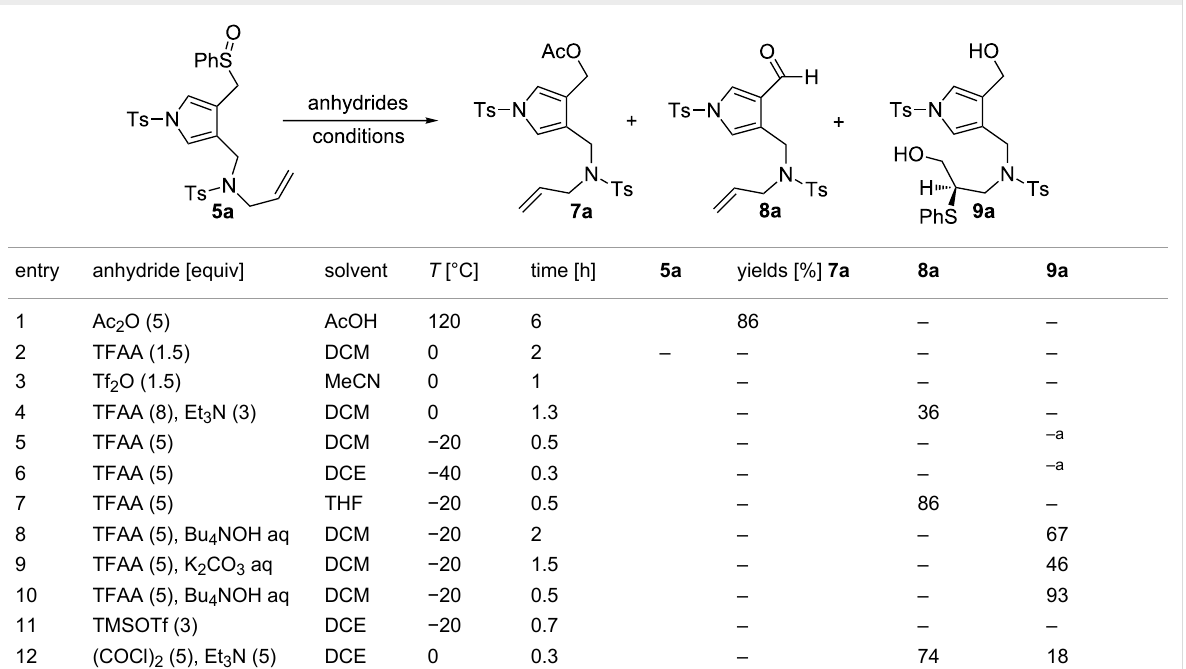
Table 1: Screening the reaction conditions for the Pummerer